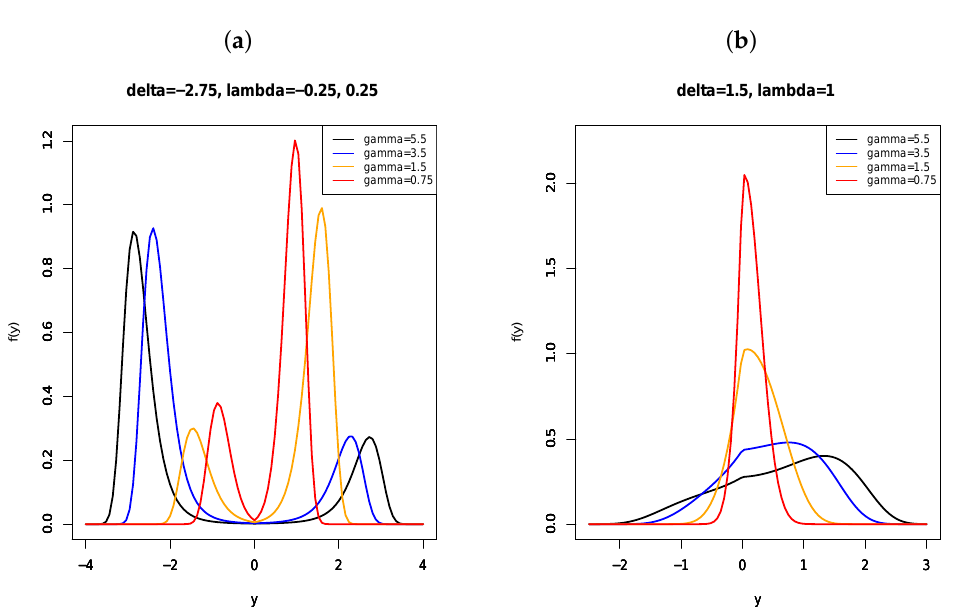
Figure 1. FSHN pdfs: ( a ) FSHN (5.5, 0, 1, − 2.75, − 0.25) (black), FSHN (3.5, 0, 1, − 2.75, − 0.25) (blue), FSHN (1.5, 0, 1, − 2.75, 0.25) (orange) and FSHN (0.75, 0, 1, − 2.75, 0.25) (red); and ( b ) FSHN (5.5, 0, 1, 1.5,1) (black), FSHN (3.5, 0, 1, 1.5,1) (blue), FSHN (1.5, 0, 1, 1.5,1) (orange) and FSHN (0.75, 0, 1, 1.5,1)